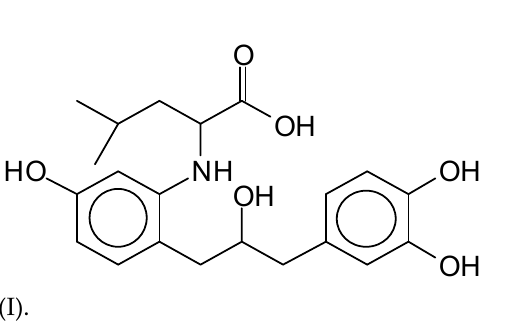
the flavonoid dimer linked to two peptide chain fragments = cross-link protein tannin